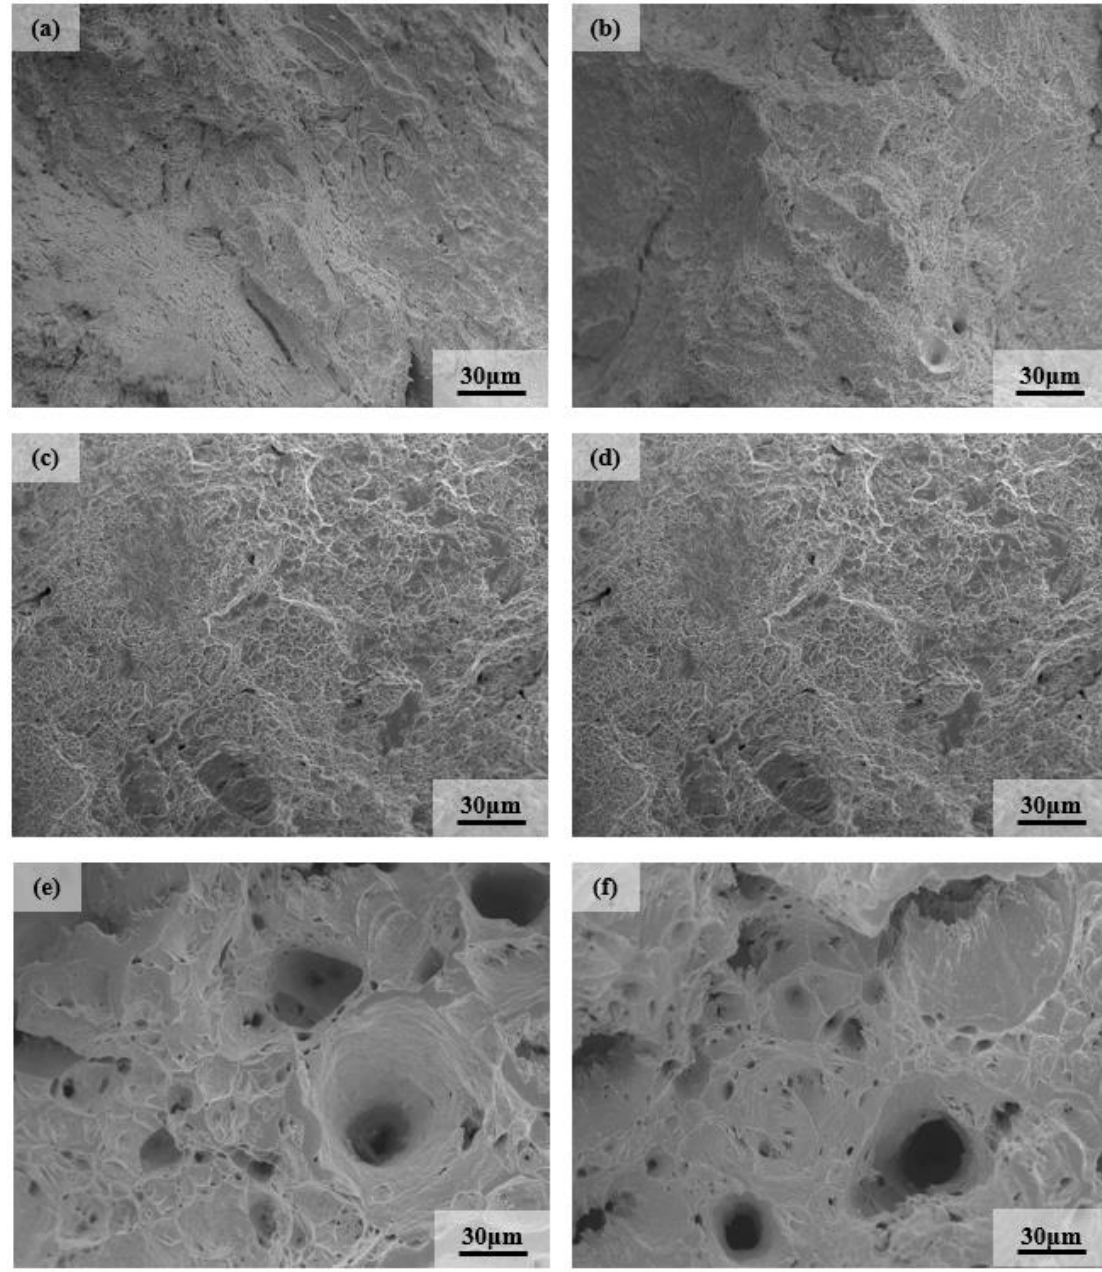
Figure 6. Tensile fracture of 9Cr–3W–3Co heat resistant steel at different temperatures: ( a ) 25 °C, ( b ) 200 °C, ( c ) 400 °C, ( d ) 500 °C, ( e ) 650 °C, and ( f ) 700 °C .